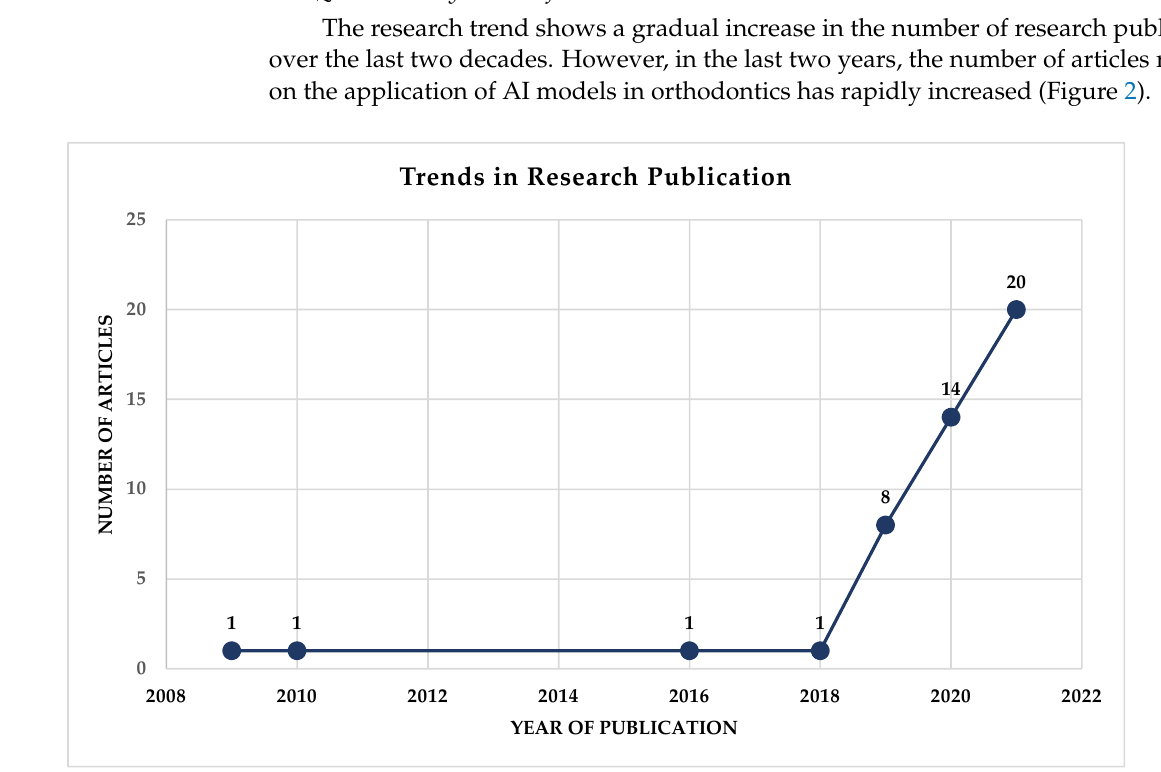
Figure 2. Trends in research publications.